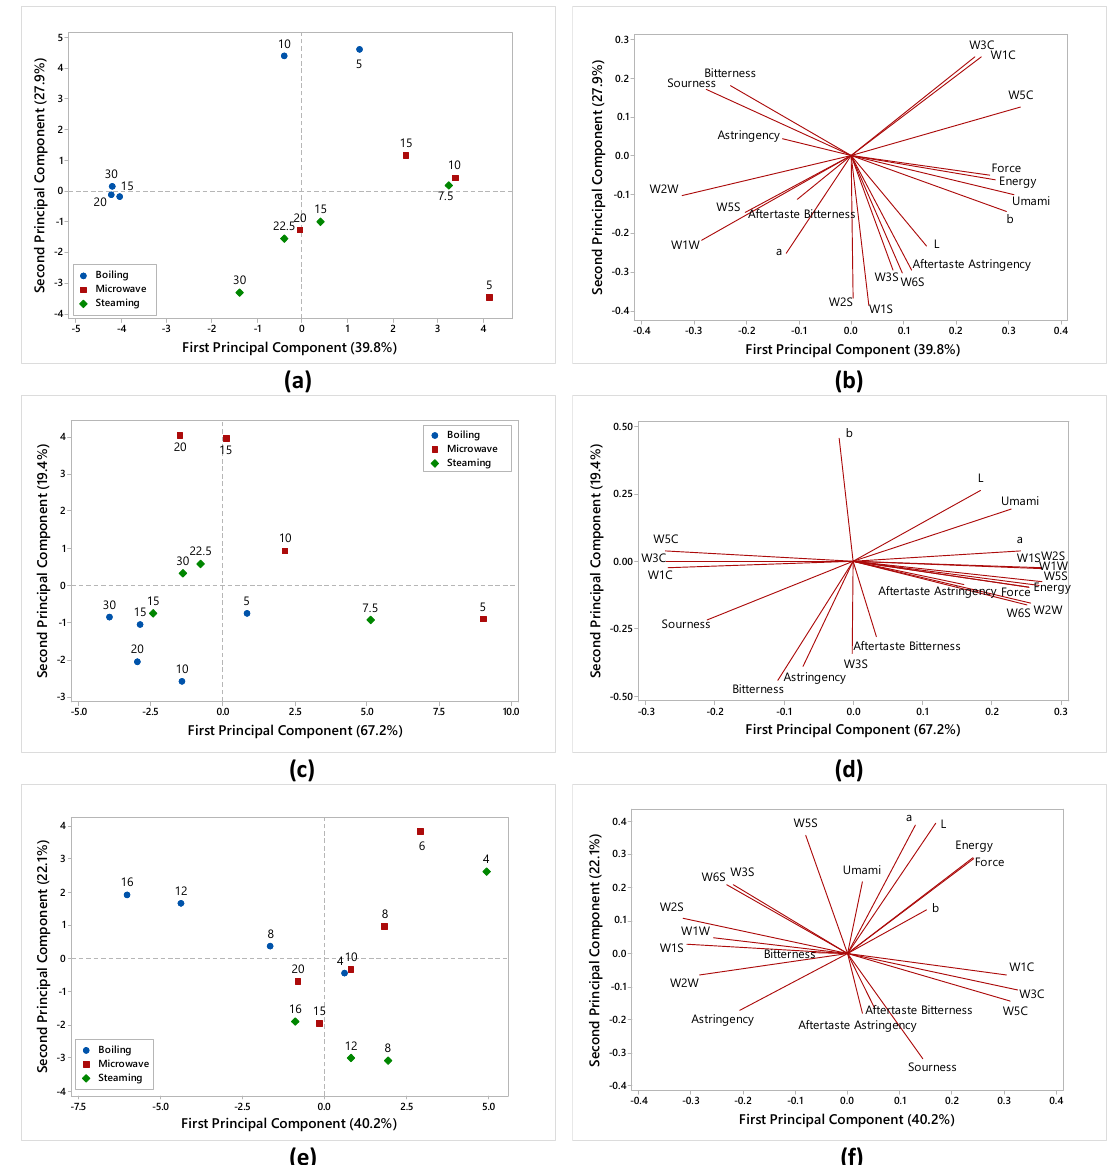
Figure 3. Principal component analysis (PCA) score plot and loading plot of e-senses and texture data collected on the ( a , b ) cauliflowers, ( c , d ) carrots and ( e , f ) sweet potatoes. In the score plots, the cooking time (min) is expressed by numbers.